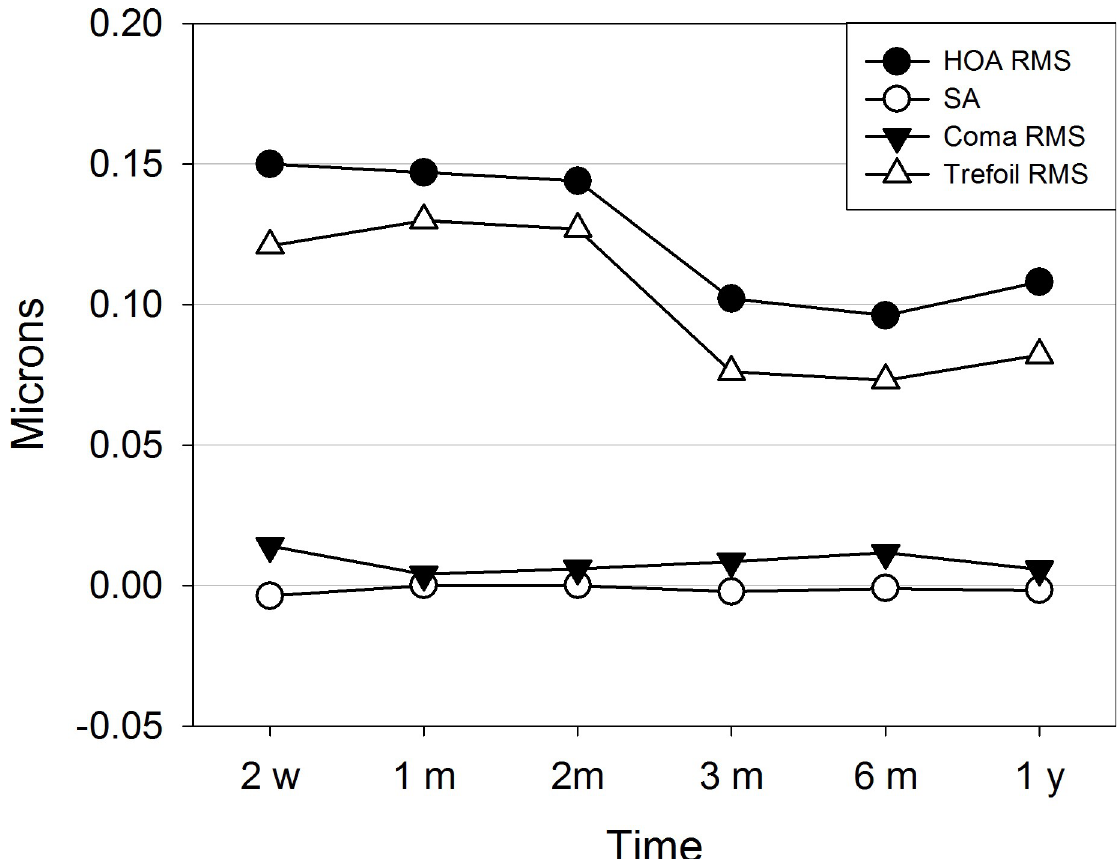
Fig 5. Mean values of induced root-mean-square of higher order aberrations (HOA RMS), spherical aberration (SA), root-mean- square of coma Zernike coefficients (Coma RMS) and root-mean-square of trefoil Zernike coefficients (Trefoil RMS). Maximum values of standard deviations (SD) are: 0.08, 0.02, 0.05 and 0.08 microns for HOA RMS, SA, Coma RMS and Trefoil RMS respectively. 4-mm pupil diameter.